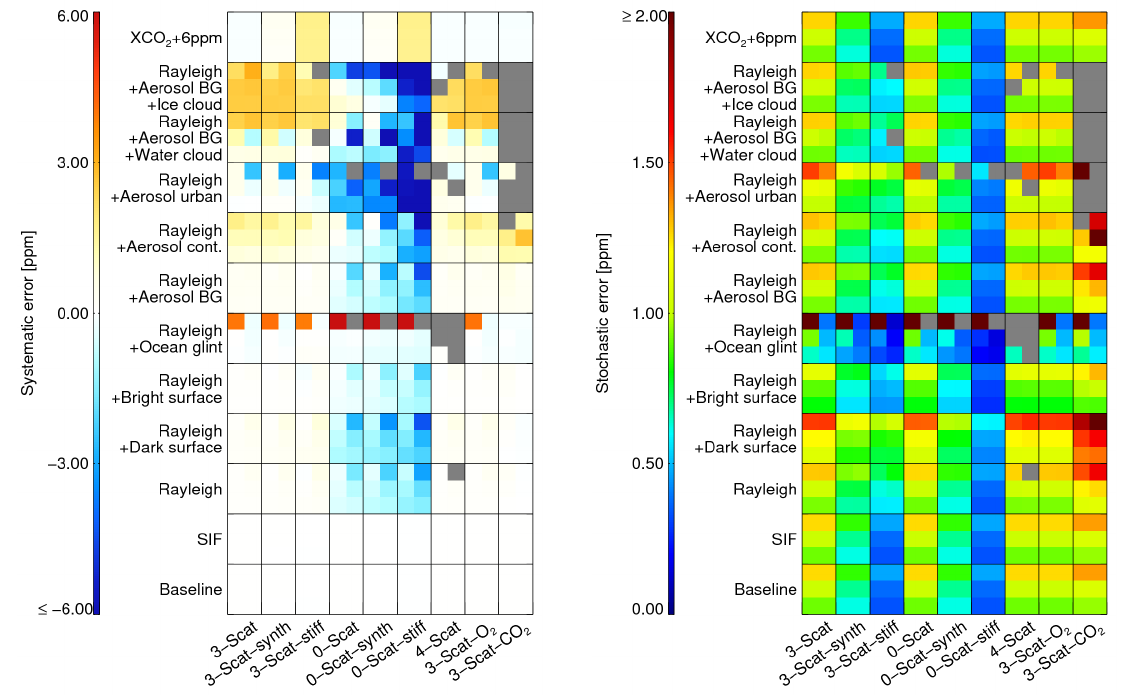
Figure 7. Error characteristics of nine retrieval setups and twelve geophysical scenarios. Each box includes six sub-boxes representing polarization parallel (left) and perpendicular (right) to the SPP as well as three solar zenith angles (20°, 40°, and 60°, from bottom to top). Gray boxes represent not converging retrievals. Left : Systematic error (retrieved minus true XCO 2 ). Right : Stochastic uncertainty as reported by the optimal estimation